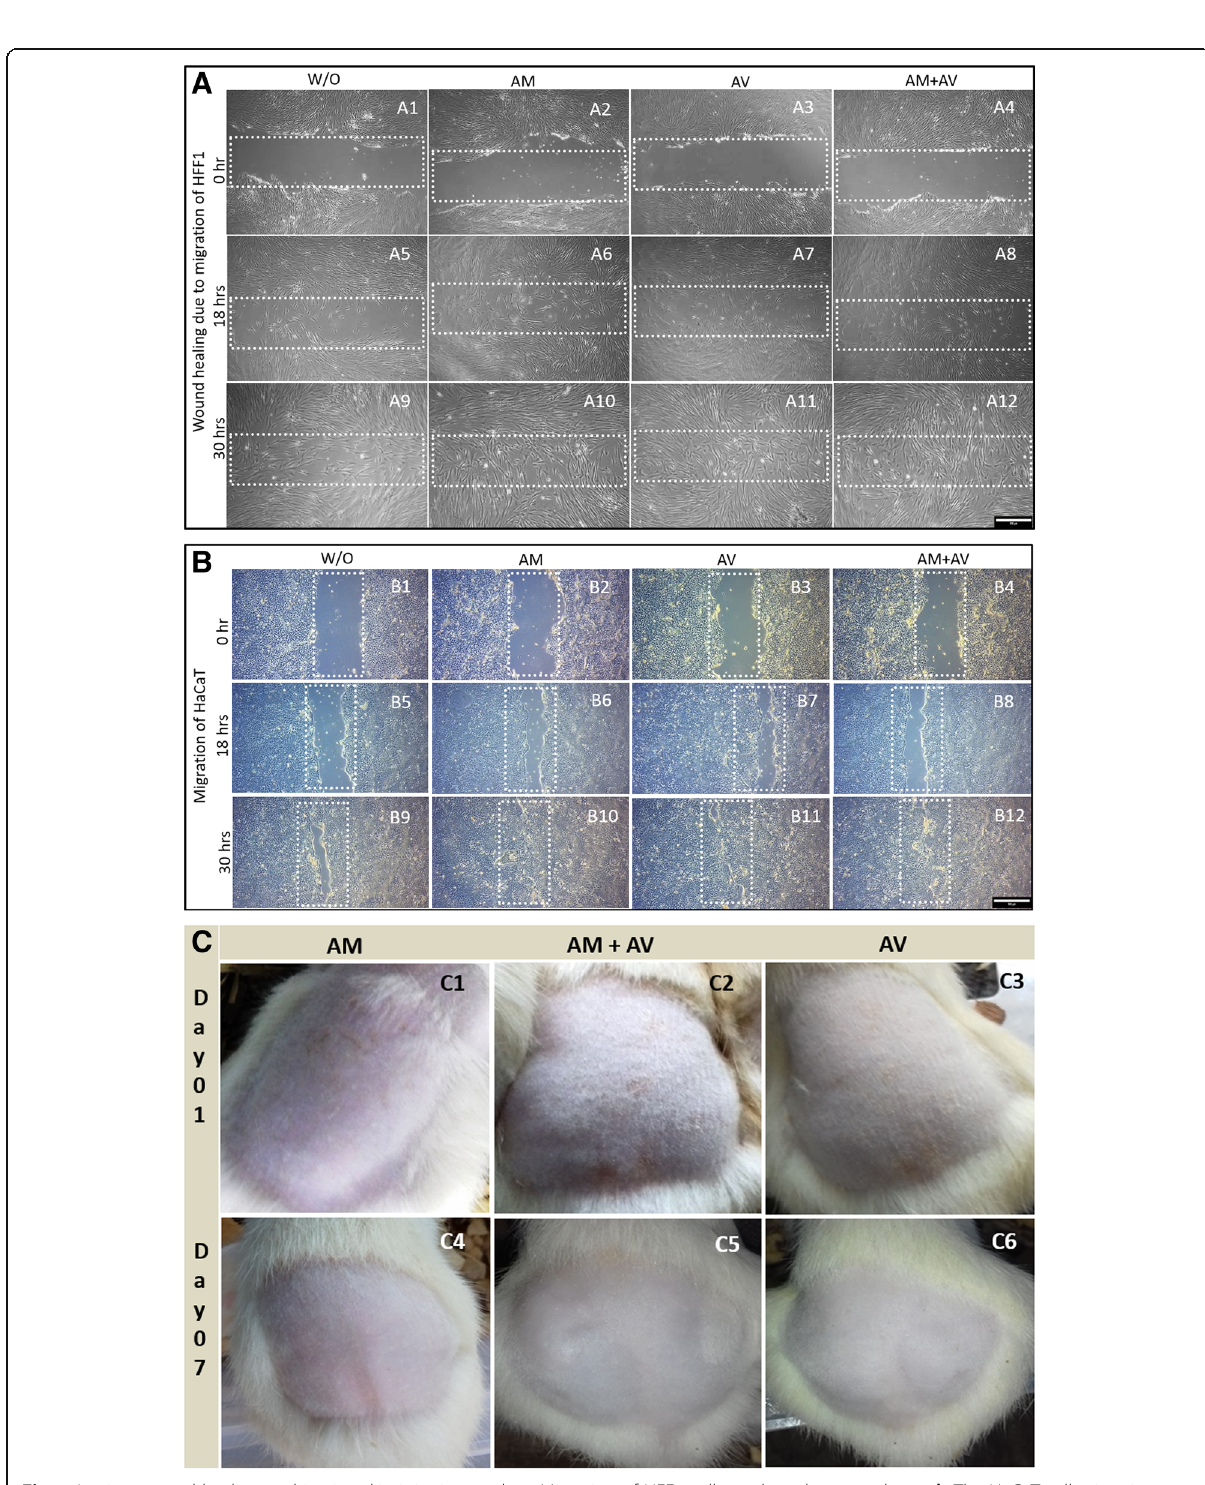
Fig. 4 In vitro wound healing and in vivo skin irritation study. a Migration of HFF1 cells to close the wound area. b The HaCaT cell migration to fill the scratch zone in presence of the three different gels in the cell culture media whereas cell culture medium without gels served as the negative control. c Topical application of the gels for irritation assay on shaved rats, which were observed from day 0 to day